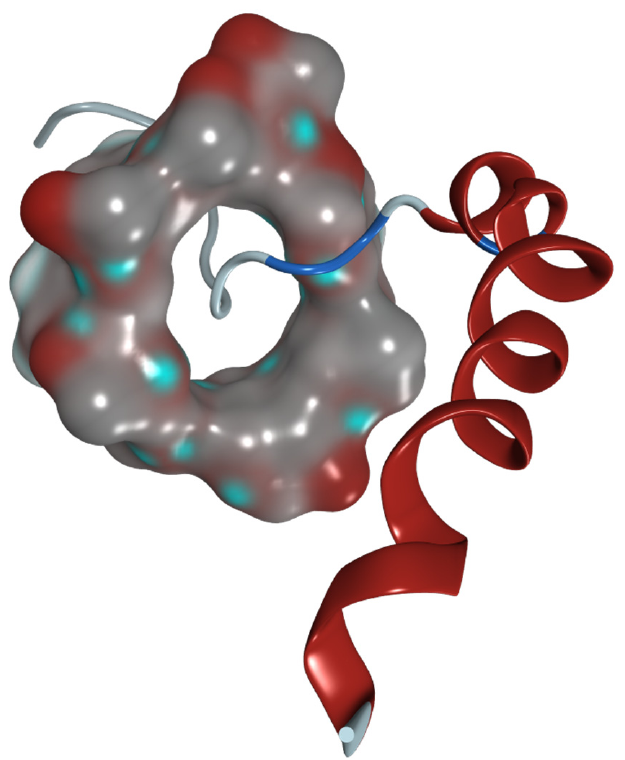
Figure 7. Hypothesized 3D model of methyl- β -cyclodextrin with neuropeptide Y. The HP- β -CD molecule is shown as a molecular surface. The peptide is presented as a ribbon model.